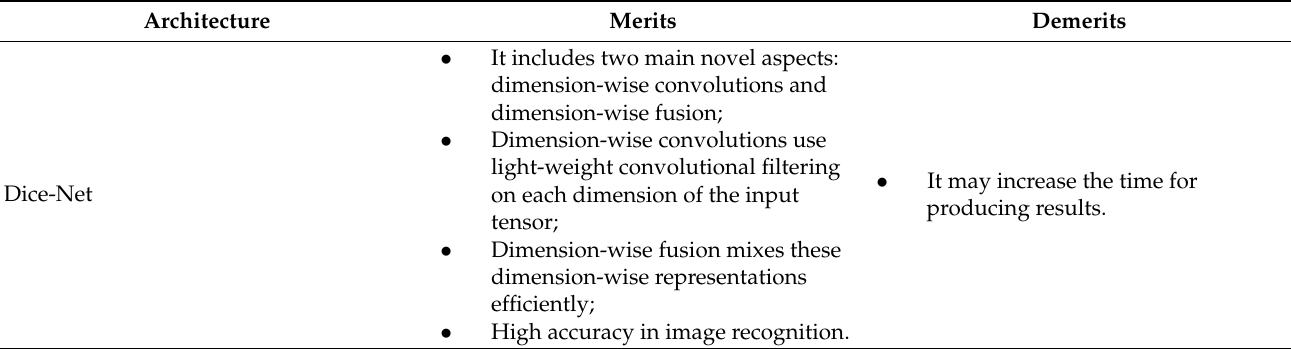
Table 9. Major issues linked with the deployment of dimension-based CNN architectures. Architecture Merits